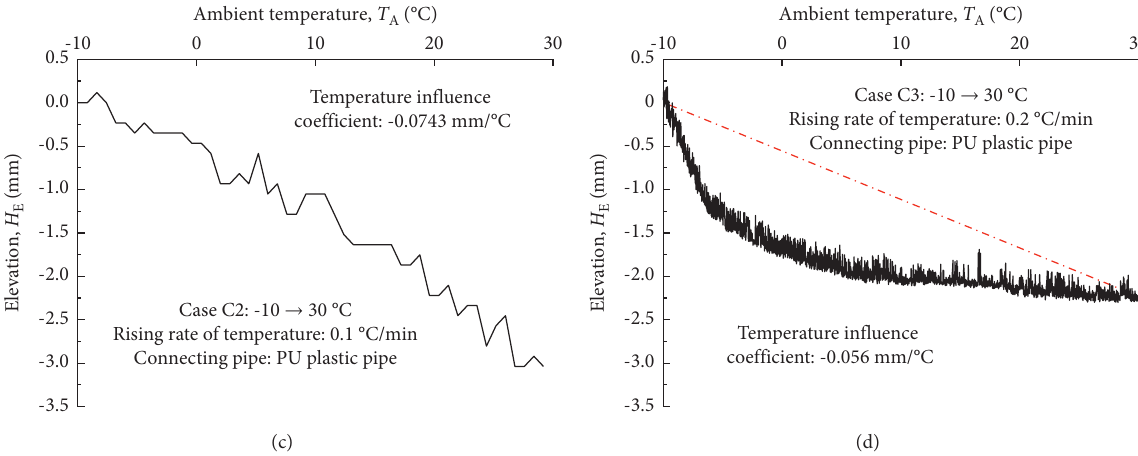
Figure 3: The influence of temperature rise rate on the measurement accuracy of the single HSL test point. (a) Case C1. (b) Case C4. (c) Case C2. (d) Case C3.